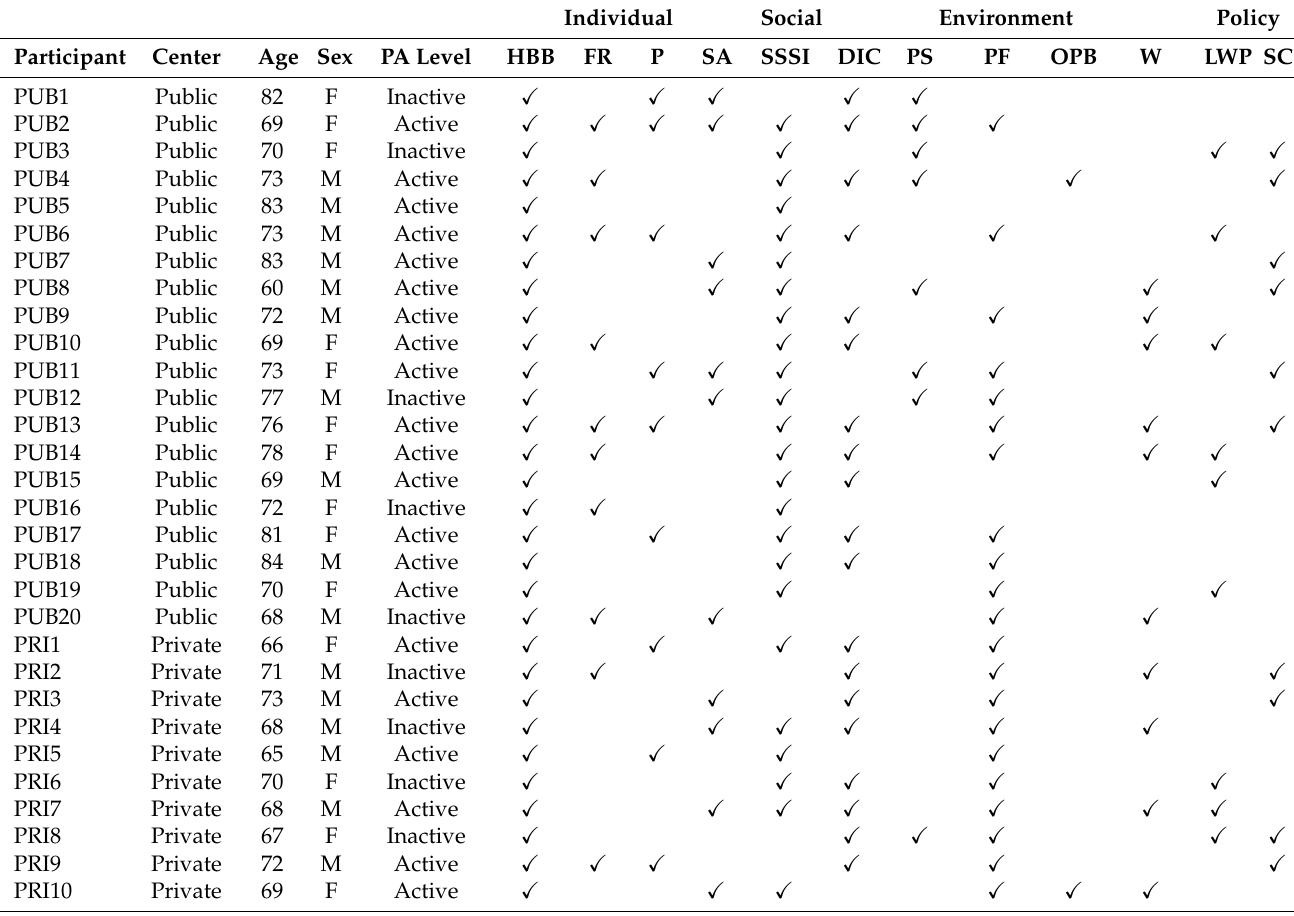
Figure 1. Studied themes in this study. Note: Number in parentheses reflect the number of times that particular theme was mentioned in the interviews. Table 2. Interview participant details. Table 2. Interview participant